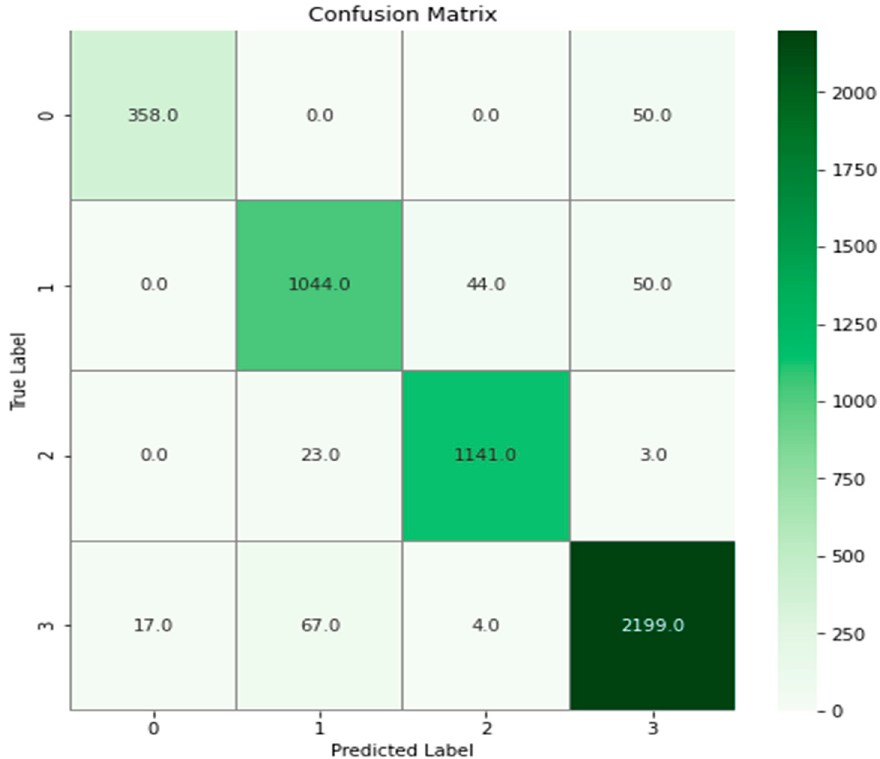
Figure 8. The confusion matrix for the FLCD system.